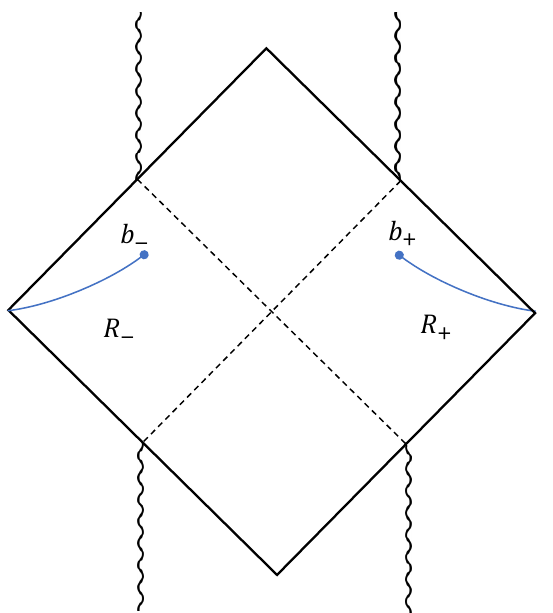
Figure 1 . Penrose diagram for the eternal Reissner-Nordström black hole without islands. Hawking radiation is assumed to lie on the region R + and R − . b ± are the boundary surfaces of R + and R − ,